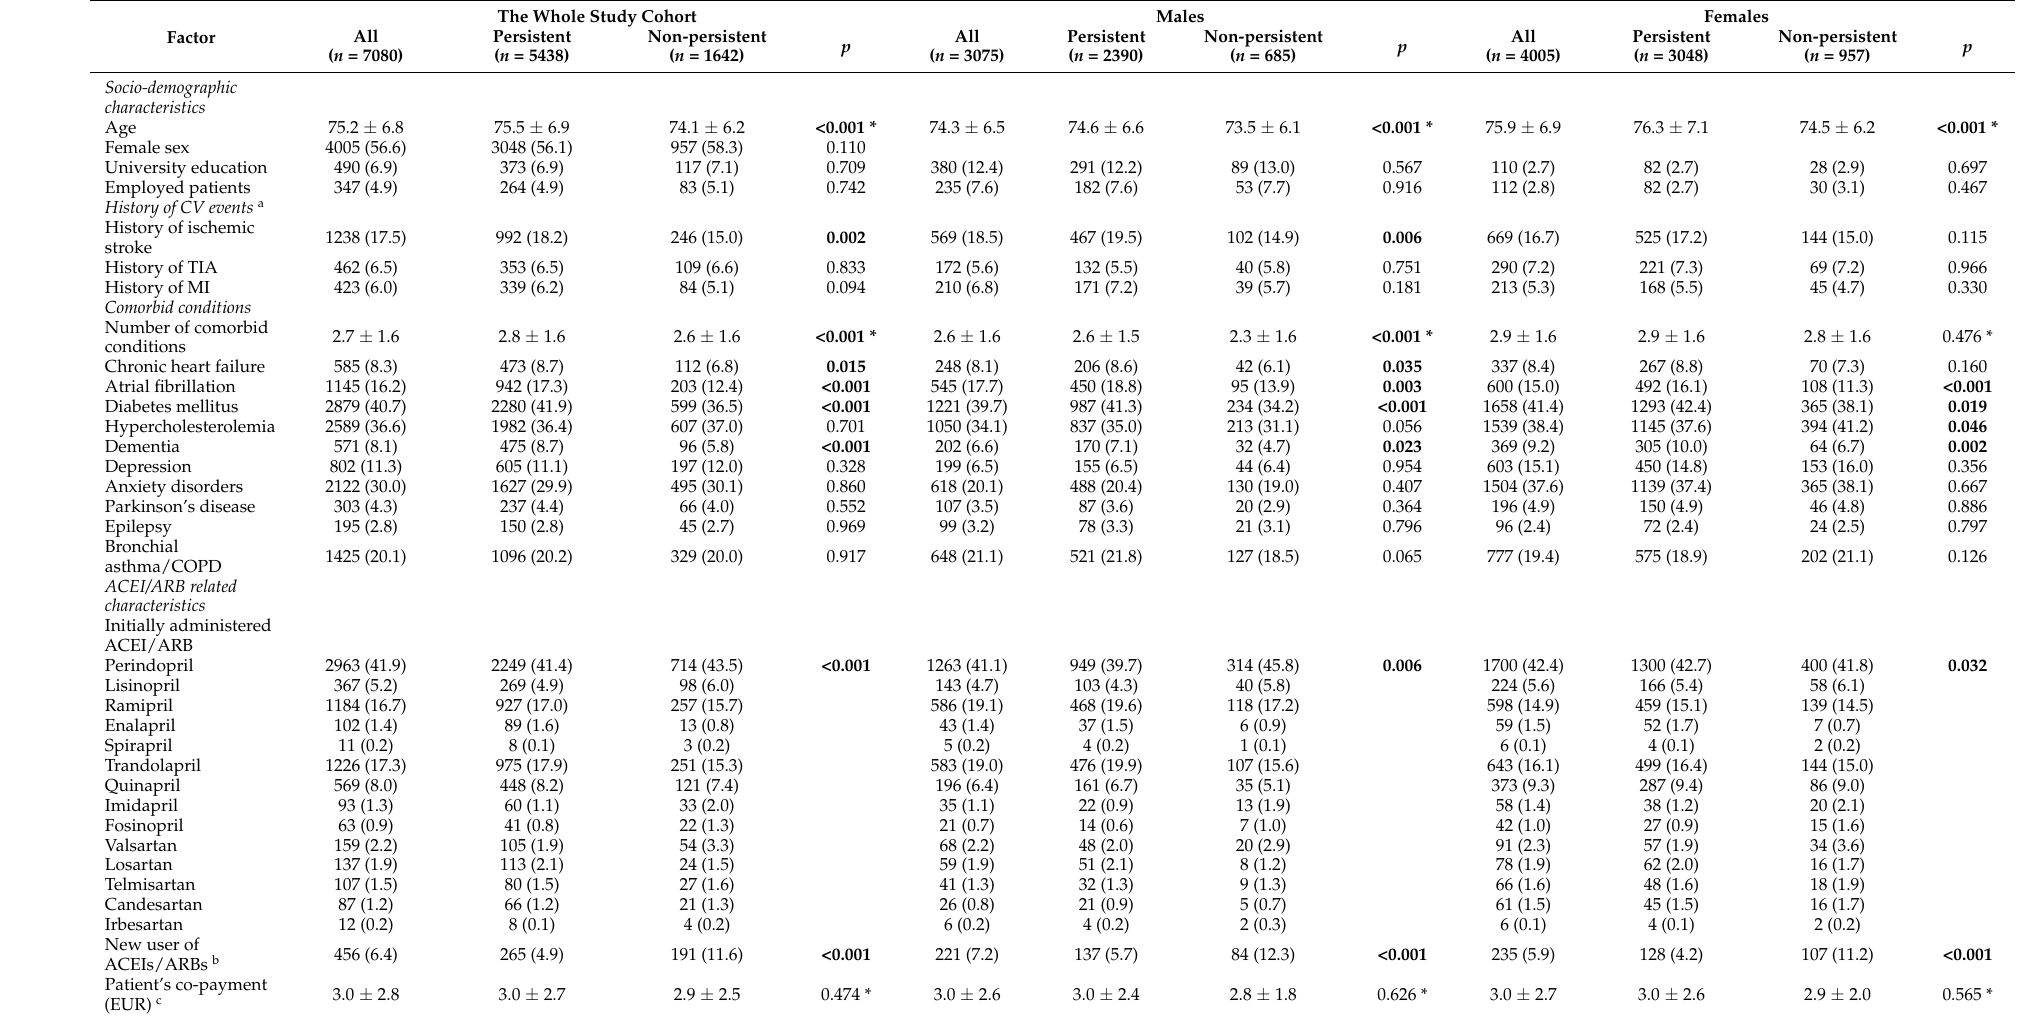
Table 1. Baseline characteristics of the study